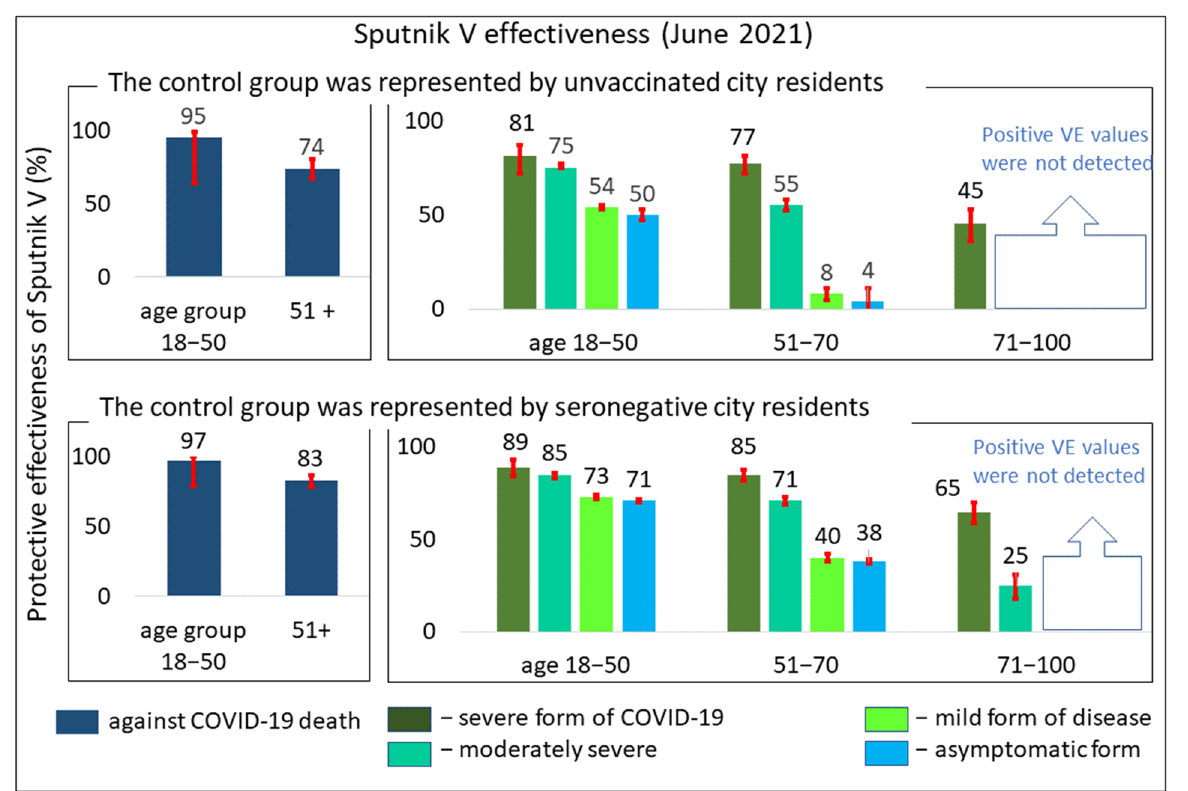
Figure 2 . Protective effectiveness of the Sputnik V vaccine against COVID-19 disease of varying severity or death (%). The upper bar charts represent calculations with control group 1, and the lower bar charts represent calculations with control group 2. All positive VE estimates in all charts are highly significant according to the chi-square test, p < 0.001. Data obtained in Moscow in June 2021. More detailed information on the age-related VE of Sputnik V is presented in Table